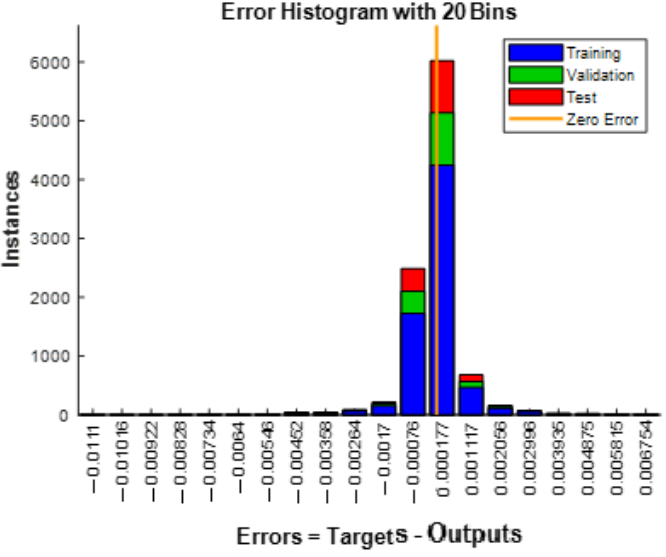
Figure 9. Error histogram with 20 neurons and 100 epochs.